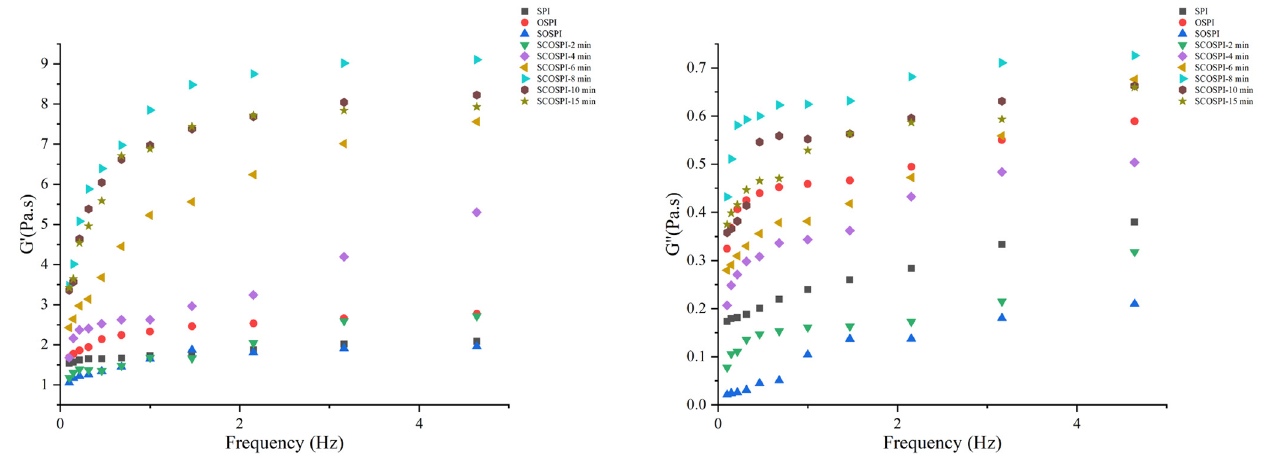
Figure 9. Viscoelastic properties of natural, oxidized soybean protein, and cavitation jet treated on soluble soybean protein oxidized accumulates at several times (2, 4, 6, 8, 10, and 15 min).